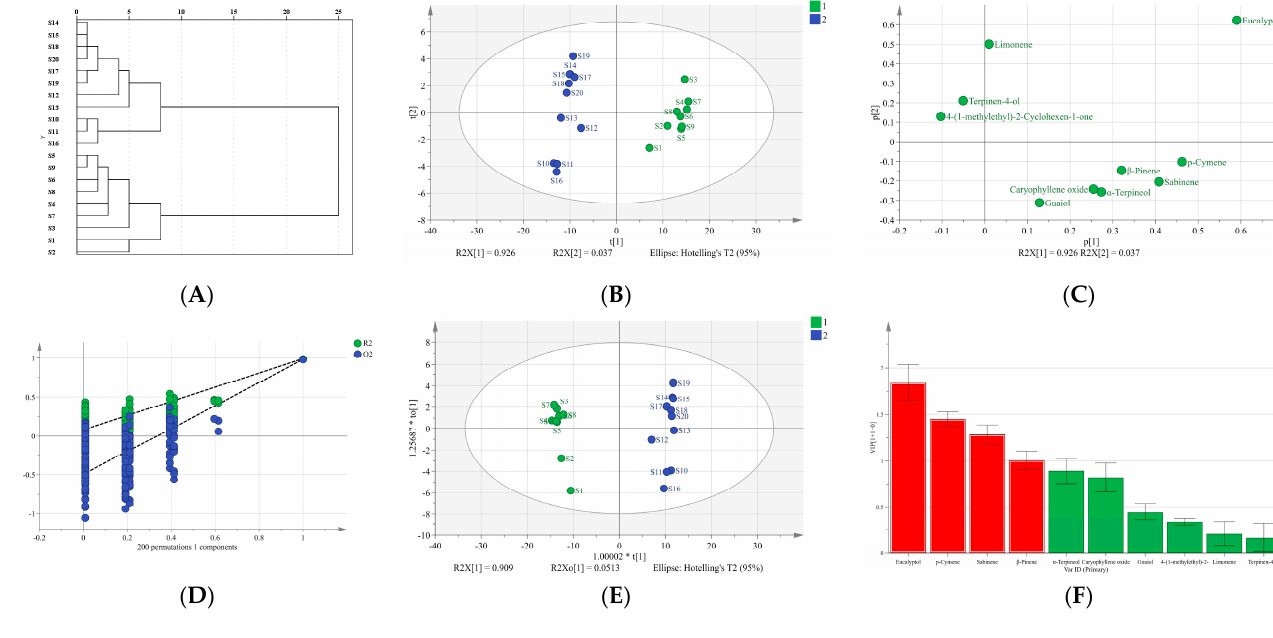
Figure 5. Multivariate statistical analysis of 10 potential effective compounds in 20 batches of Oleum Cinnamomi . Hierarchical cluster analysis dendrogram ( A ). Principal component analysis: score plot ( B ), loading plot ( C ). Orthogonal partial least squares-discriminant analysis (OPLS-DA): 200 response permutation tests for the OPLS-DA model ( D ), score plot ( E) , and VIP plot ( F